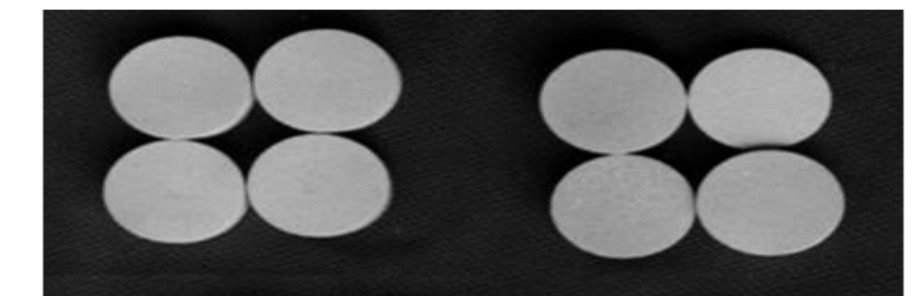
Fig.2: Samples prepared by flame spraying